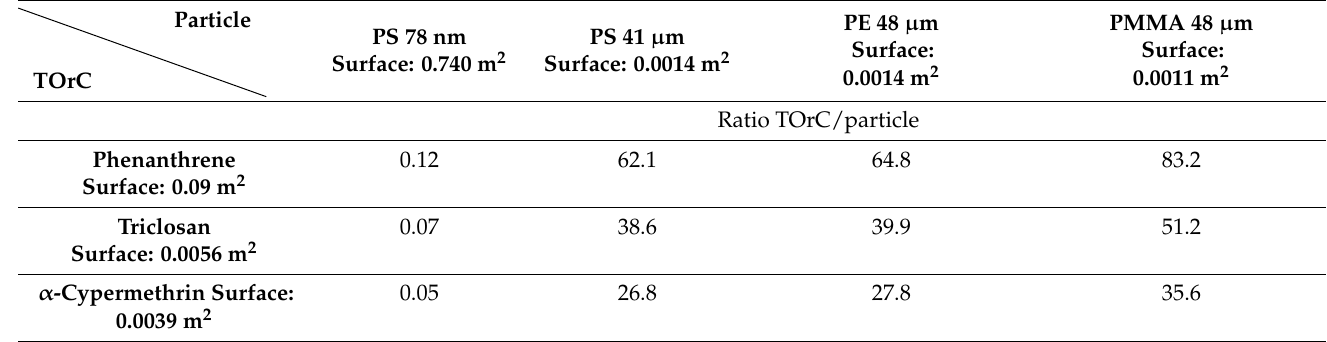
Table 2. Ratio between TOrC surface area and particle surface area for TOrCs (phenanthrene, triclosan, α -cypermethrin) amount of 10 µ g (=1 mg/L) each and a particle amount (PS78 nm (PS78), PS 41 µ